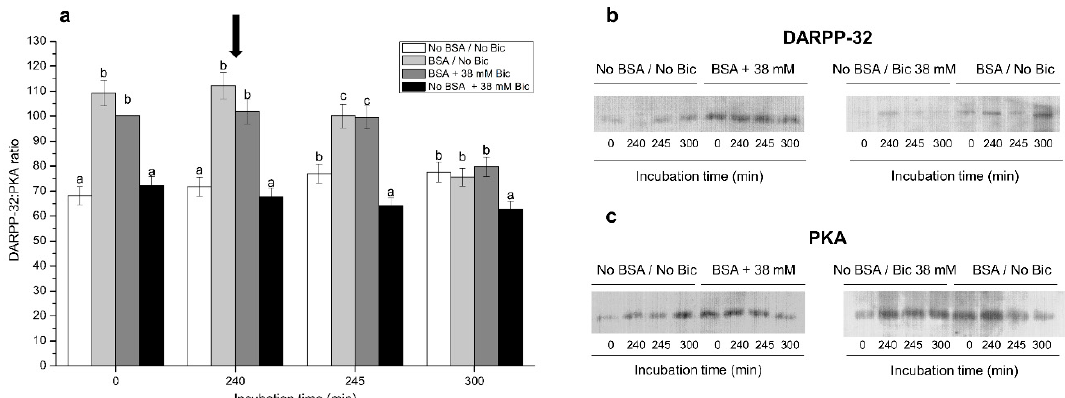
Figure 7. ( a ) Ratios between phosphorylated DARPP-32 and PKA following incubation with different concentrations of bicarbonate (Bic; 0 mM, 38 mM) and BSA (0, 5 mg/mL) for 300 min. The black arrow indicates the time at which 10 µ g/mL of progesterone was added (i.e., 240 min) to induce acrosome exocytosis. Different superscripts (a–c) indicate significant differences ( p < 0.05) between treatments within the same time point. Data were corrected to a basal arbitrary value of 100 for the control point, which corresponded to the incubation in the medium containing BSA and 38 mM bicarbonate at 0 min. Results are shown as mean ± SEM for 12 independent experiments. Representative blots for DARPP-32 ( b ) and PKA ( c ) after 0, 240, 245 and 300 min of incubation with No BSA/No Bic; BSA + 38 mM Bic; No BSA + 38 mM Bic; or BSA/No Bic.